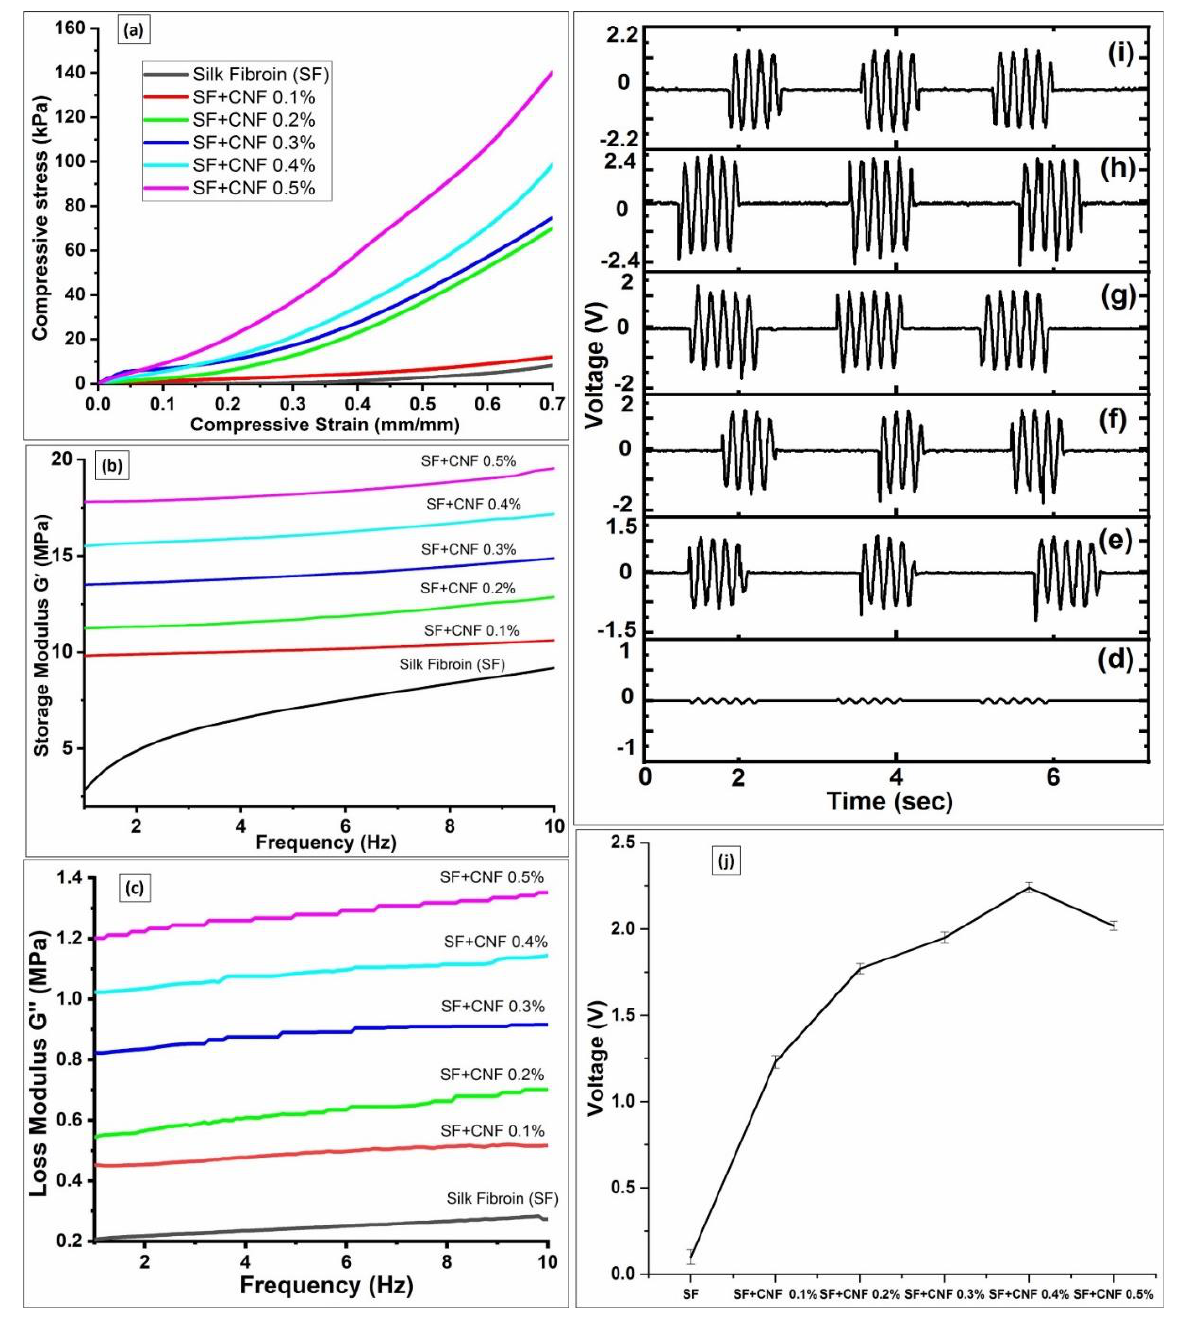
Figure 6. ( a ) Stress vs. strain analyses for SF samples with different CNF concentrations; ( b ) Storage modules vs. frequency analysis for the SF samples with different CNF concentrations; ( c ) Loss modulus vs. frequency analyses for SF samples with different CNF concentrations; Piezoelectric voltage generated for the samples composed of: ( d ) the pure SF, ( e ) the SF with CNFs density equal to 0.1%; ( f ) the SF with CNFs density equal to 0.2%; ( g ) the SF with CNFs density equal to 0.3%; ( h ) the SF with CNFs density equal to 0.4%; ( i ) the SF with CNFs density equal to 0.5%; ( j ) Peak average values of generated piezoelectric voltage for SF samples with different CNF concentrations.